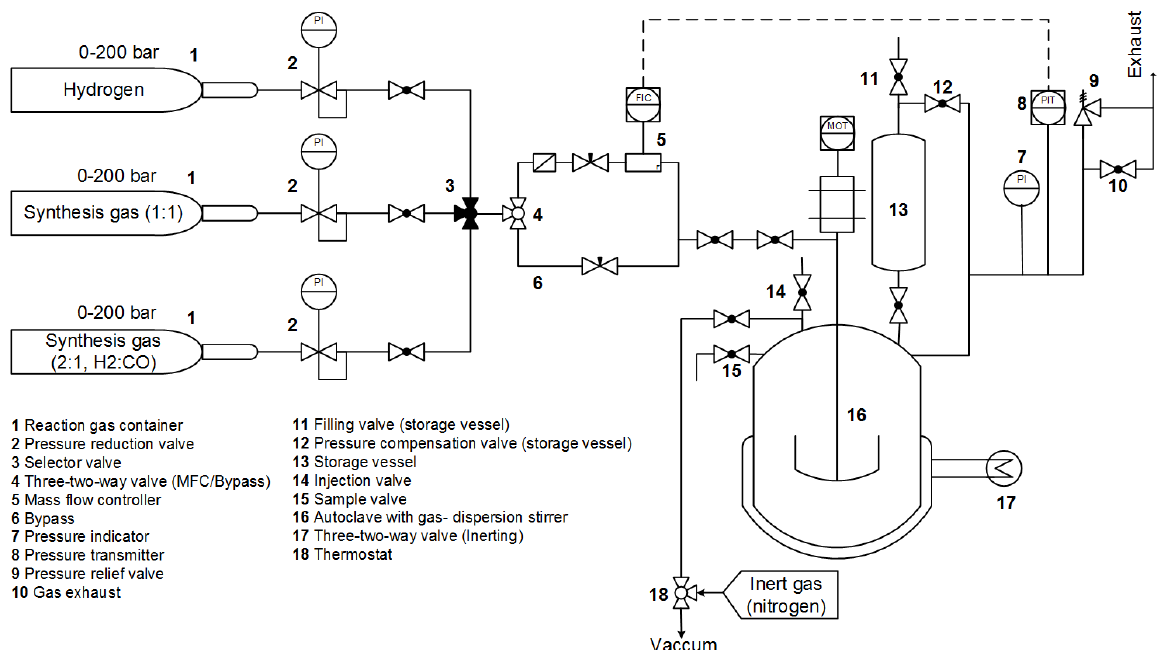
Figure 2. Experimental setup for the reductive